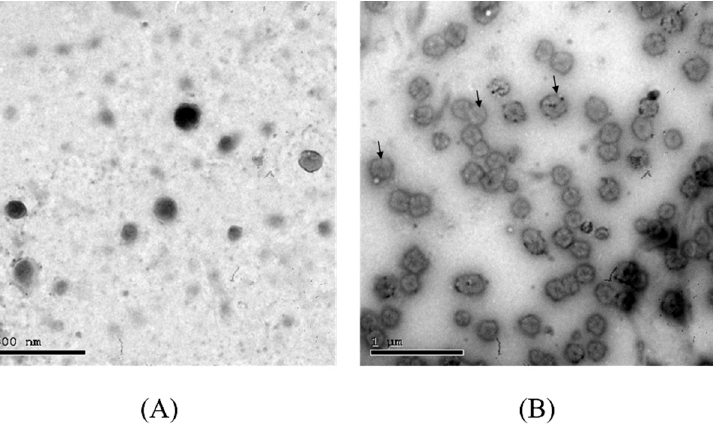
Figure 2. Transmission electron microscopy images of empty ( A ) and chloroquine-loaded niosomes ( B ). Scale bars represent 0.5 and 1 µm, respectively. Particles display rounded shapes with well- defined edges, as demonstrated by the arrows.